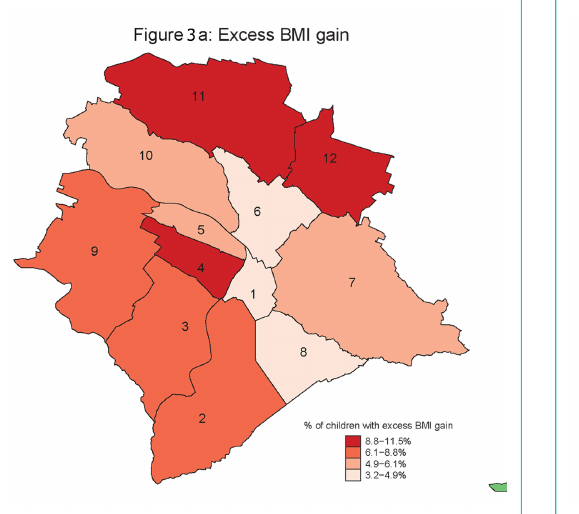
Figure 3b: Map of the City of Zurich showing the proportion of children from southern/eastern Europe or outside Europe in differ- ent districts (intensity of the colour symbolises the quantity of pro- portion; dark = high proportion, light = low proportion) (n = 7145).